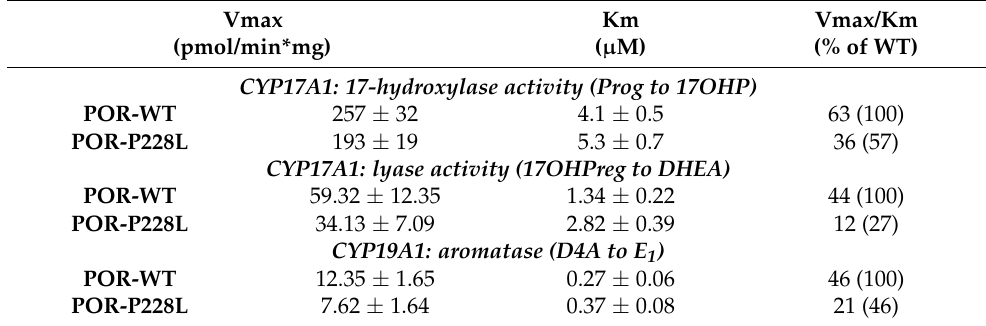
Table 4. Calculated kinetic parameters for activities of CYP17A1 and CYP19A1 and supported by WT and P228L POR. Comparison of the steroidogenic enzyme activities supported by WT or P228L mutant of POR. All data are Vmax/Km, shown as a percentage of the wild-type control, set at